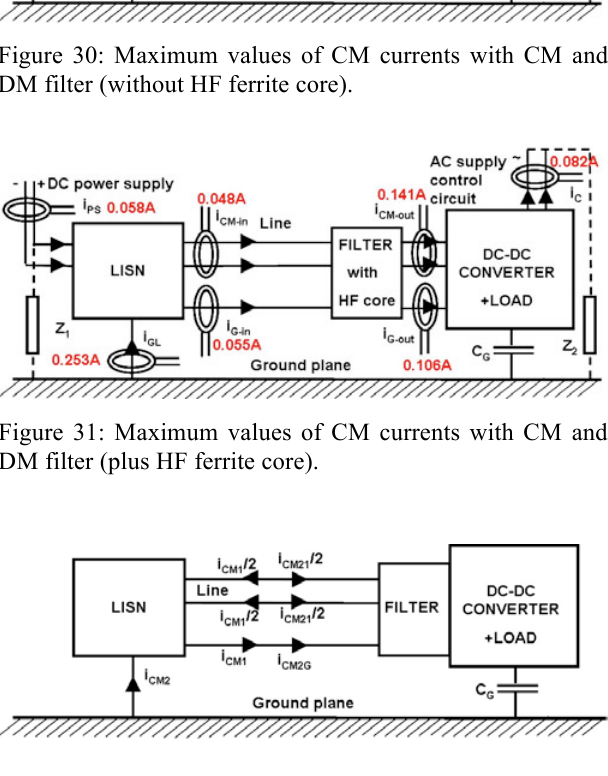
Figure 32: Distribution of the propagation paths of the two CM currents.